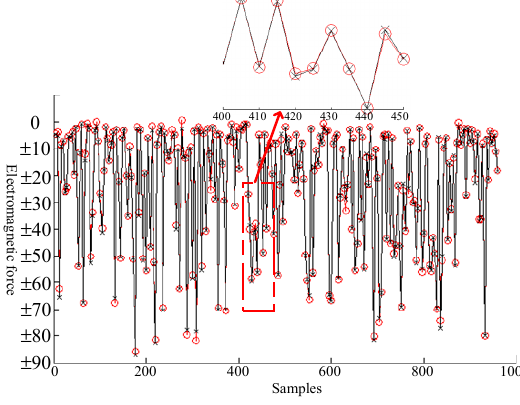
Figure 8. Random error comparison.